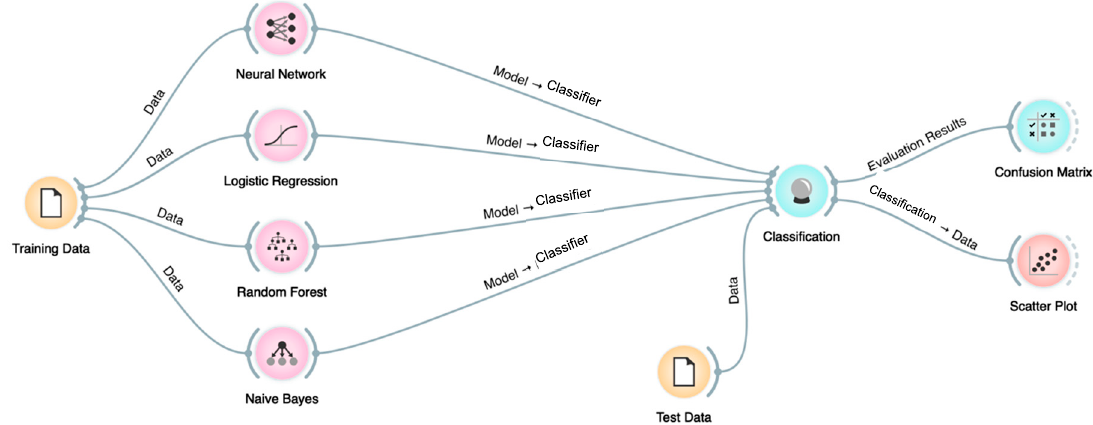
Figure 5. Visual overview of the model training and testing process in Orange.